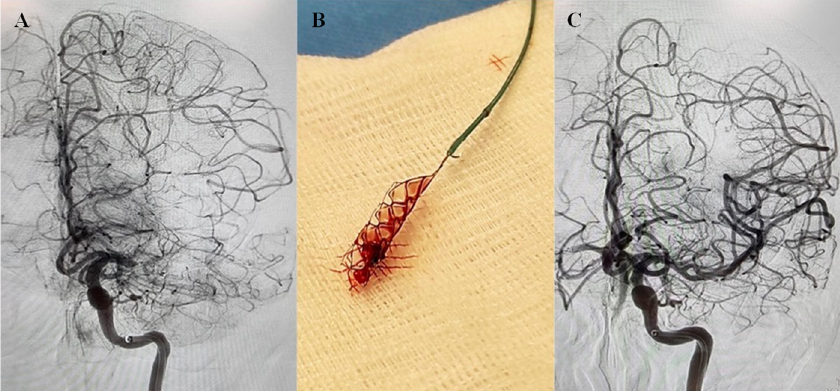
Figure 1. Cerebral Angiogram of acute stroke with left middle cerebral artery (MCA) occlusion. ( A ) Cerebral angiograph showing left MCA M1 occlusion. ( B ) After two passes with Solitaire (4 × 20 mm), vessel recanalizes (TICI 3). ( C ) Post-thrombectomy angiogram showing complete recanalization of the left MCA.